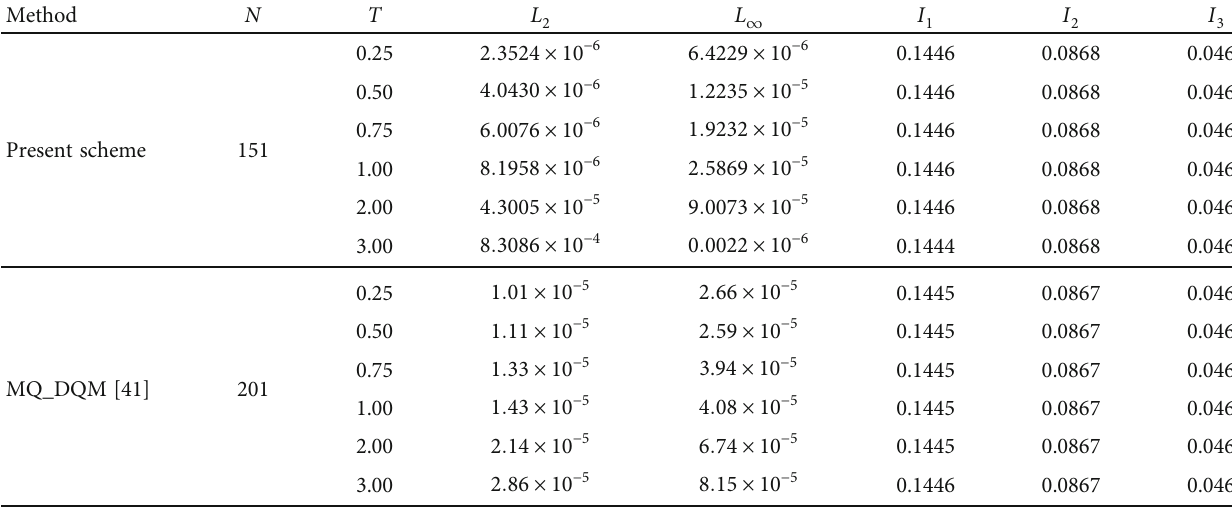
Table 2: Experimental evaluation of single soliton: Δ t = 0 : 0005 :